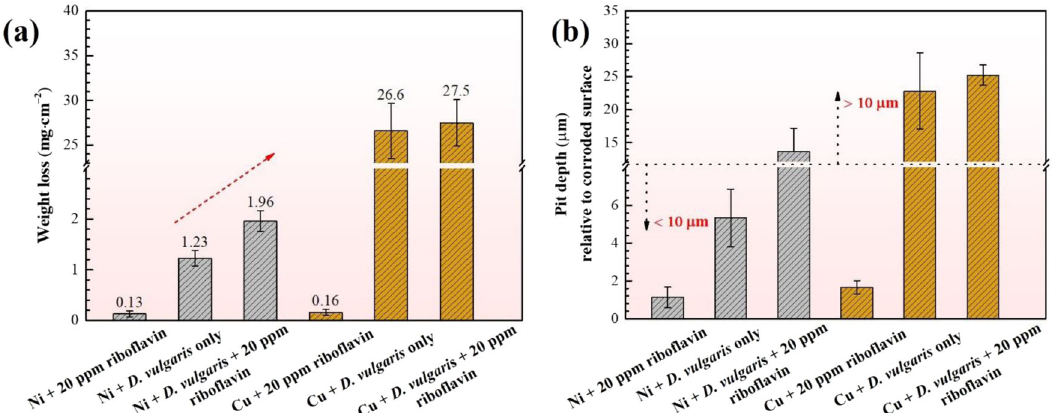
Fig. 6 Weight losses and pit depth. a Weight losses and b pit depth of Cu and Ni coupons after the 7-d incubation in the D. vulgaris media without and with ribo fl avin. (Error bars stand for the standard deviations from at least three independent